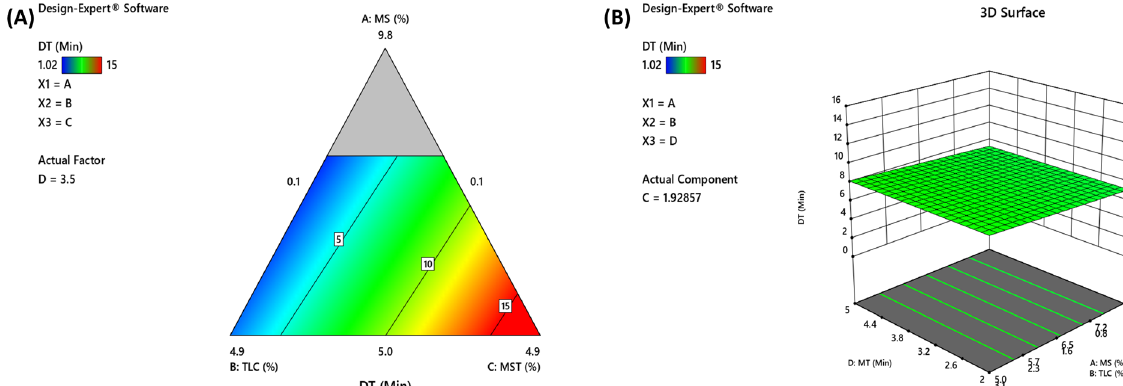
FIGURE 2 - (A) Contour plot and (B) 3D Surface Plot for response DT.